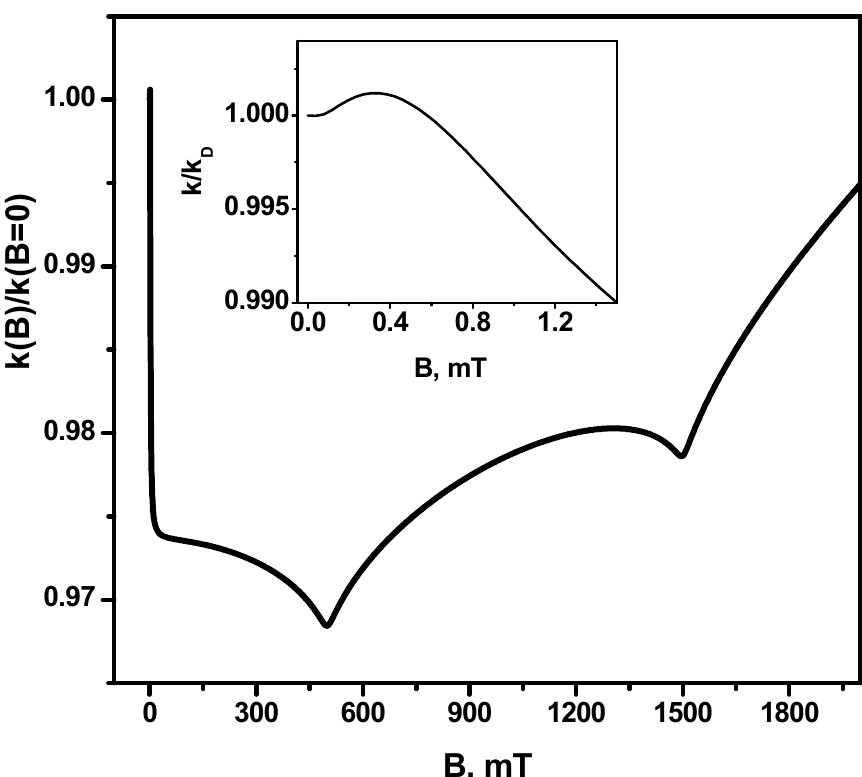
Figure 2. Magnetic field effect (MFE) in the recombination rate constant k(B)/k(B = 0). Insertion— magnetic field effect on the range of small magnetic fields. The other parameters are the same as in Figure 1.